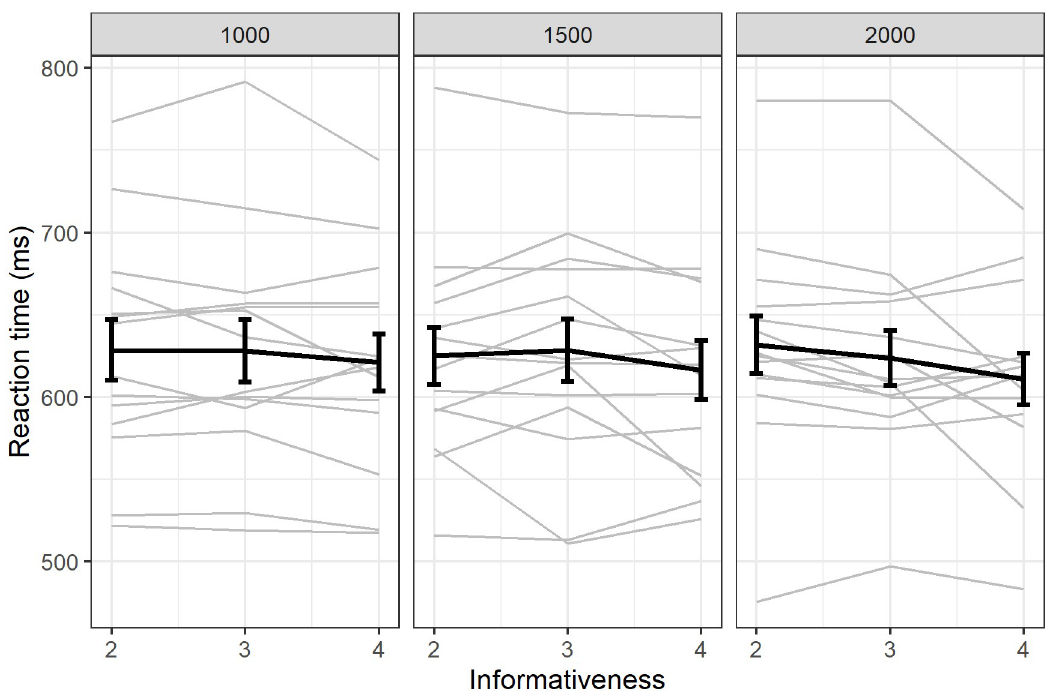
Fig 7. Reaction times for successful revealed trials. Individual responses (light grey) with group average (error bars represent standard error).